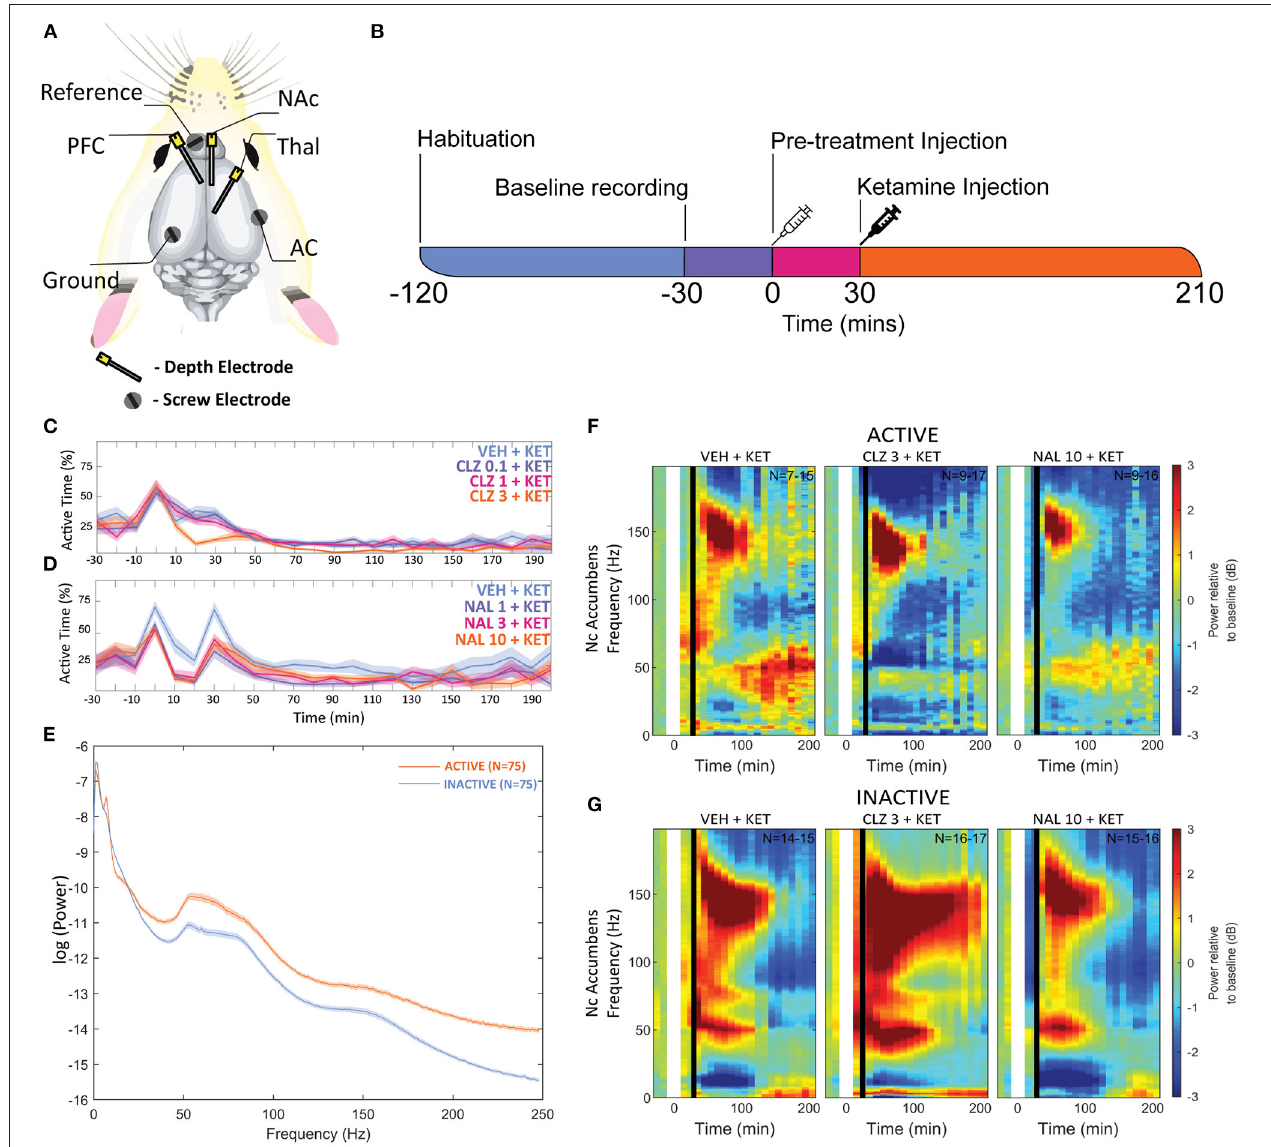
FIGURE 1 | (A) Overview of electrode placements. (B) Diagram of experimental procedures in one recording session. Plots depicting the mean proportion of time spent in Active state for Clozapine (C) and Naltrexone (D) groups. Pre-treatment doses given in mg/kg. (E) A plot of mean baseline power in the Active and Inactive state taken at the NAc between “-30” and “0” min between 0 and 250Hz. (F,G) Heatmaps depicting grand mean LFP [0–200Hz] for an exemplar brain region, the NAc, for animals given VEH + VEH, VEH + KET, NAL + KET, and CLZ + KET during Active (F) and Inactive (G) epochs. Pre-treatment doses given in mg/kg. The first (leftmost, evenly green) timebin at the start of each plot indicates the baseline recording, to which the rest of the session was normalised. The white vertical bar at time 0 represents pre-treatment injection, and the black bar at time 30 indicates KET injection. Colours indicate change (in dB, which is logarithmic) to baseline. Number of subjects is given as a range (lowest-highest n subjects included in a timebin) in the top right of each plot; group sizes were equal, however not all subjects were included in all timebins as inclusion was conditional on 1) histological validation of electrode placement and 2) sufficient time spent in the Active or Inactive state in any given timebin. Full heatmaps for other regions can be found in Supplementary Information . VEH, saline; KET, ketamine 10 mg/kg; CLZ, clozapine 3 mg/kg; NAL, naltrexone 10